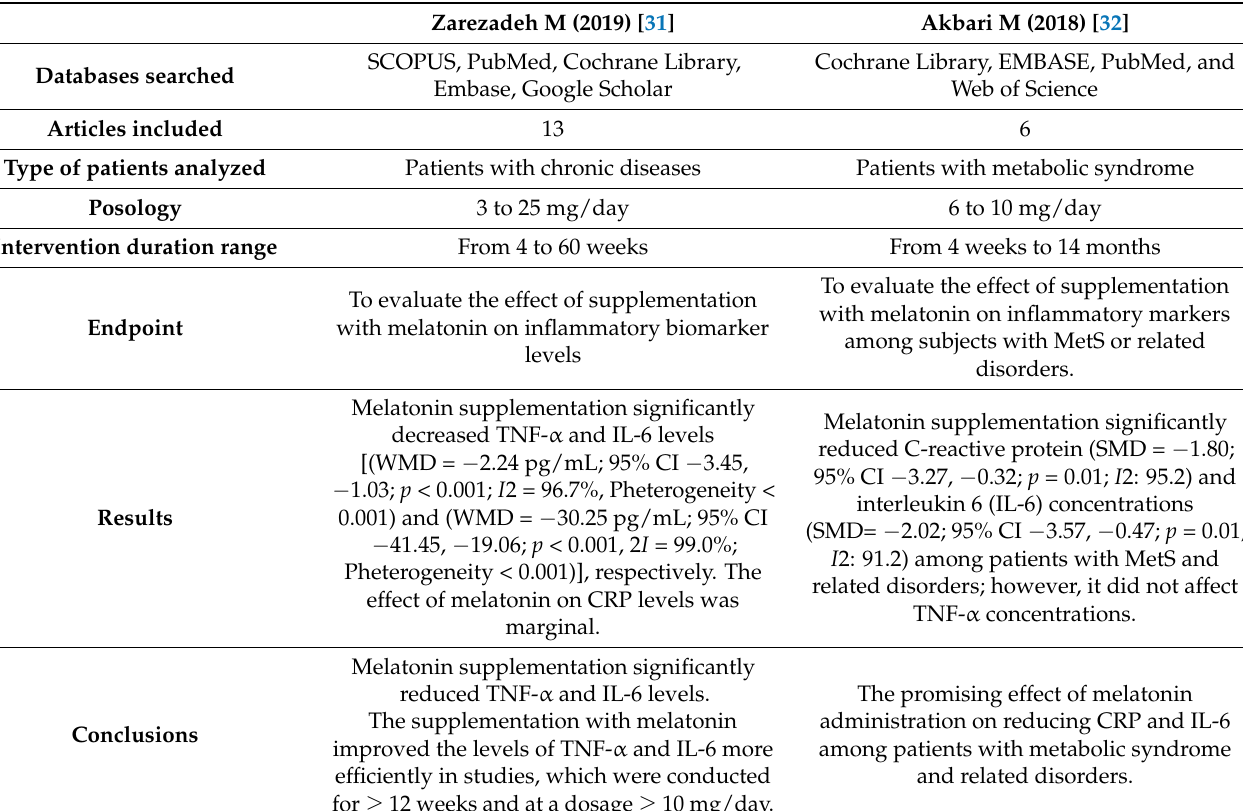
Table 5. Melatonin: characteristics of the included systematic